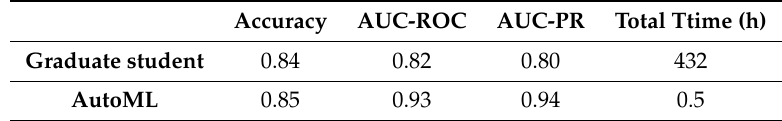
Table 3. Comparison of AutoML and the graduate student’s classification performances and total time on UCI test set.